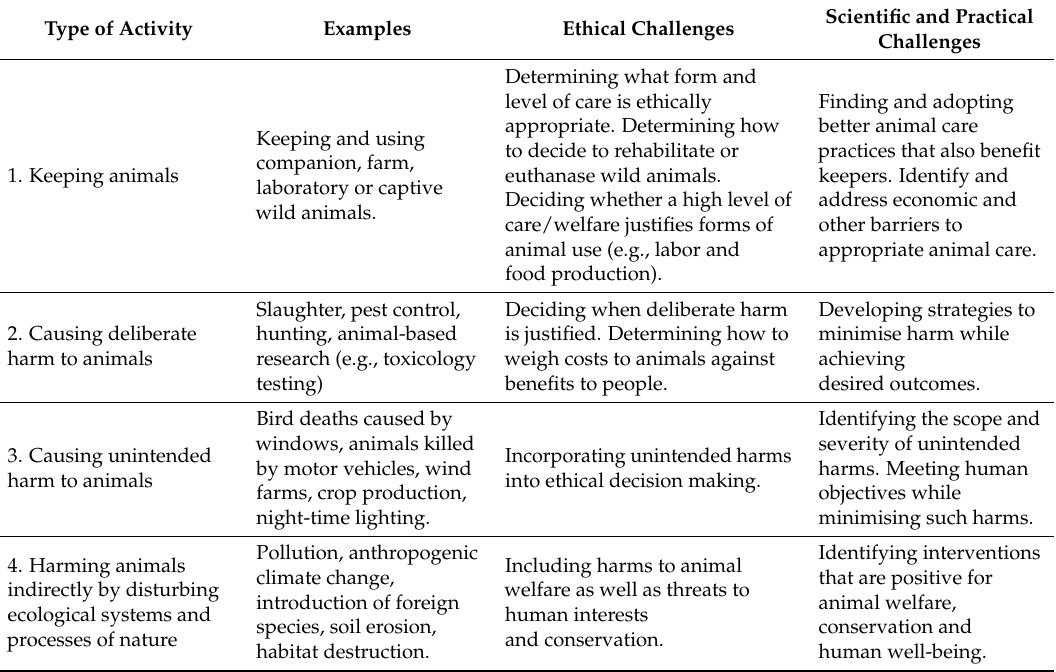
Table 1. Types of human activity with the potential to harm animals, and their associated ethical, scientific, and practical